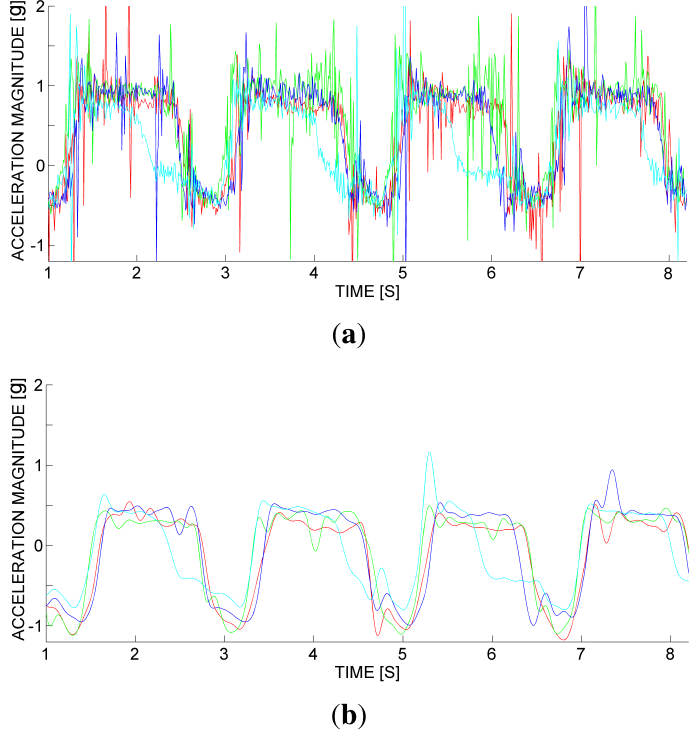
Figure 4. A pilot scenario of vertical acceleration magnitude against time, with 4